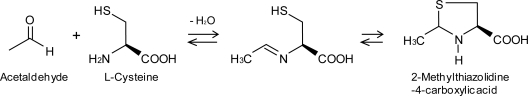
Reaction between acetaldehyde and l-cysteine.